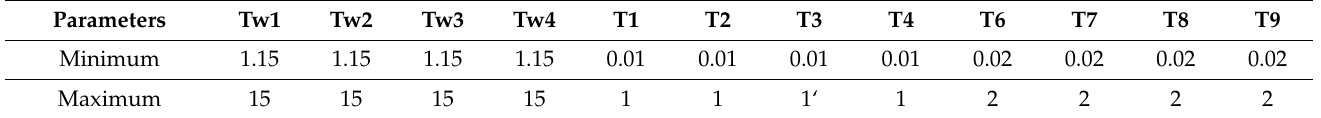
Table 2. Typical range of dual-input optimized parameters.